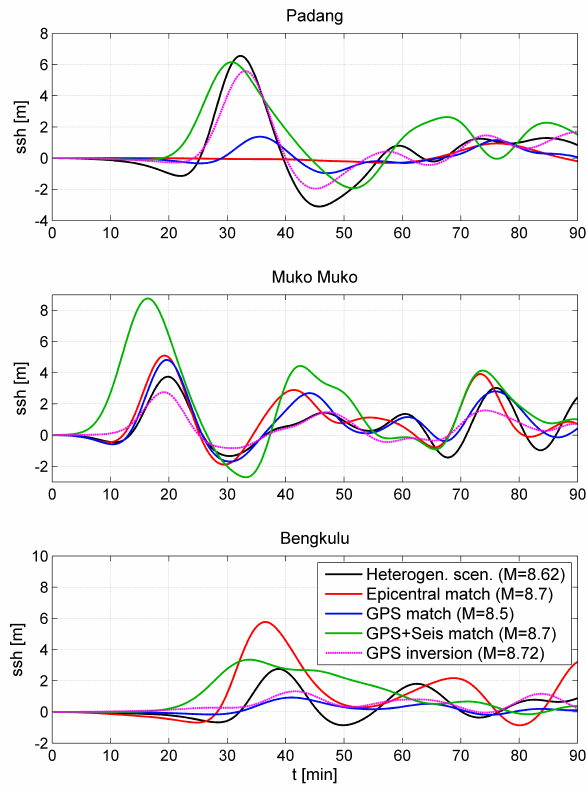
Fig. 6. Mareograms at the three tide gauges (for location see Fig. 5) for the different inversion methods.